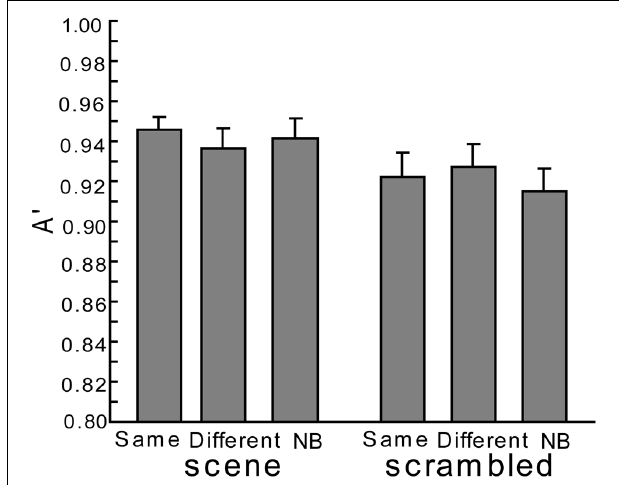
FIGURE 3 |The accuracy (A’) of the current experiment. Error bars are standard errors of means.